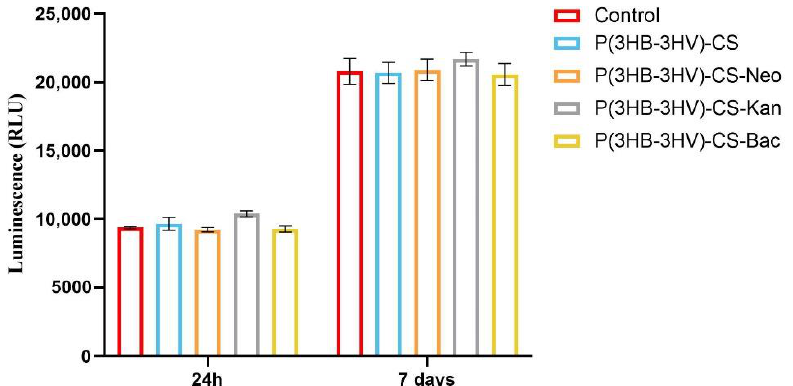
Figure 7. Graphic representation of the H 2 O 2 levels in human dermal fibroblasts cell cultures exposed for 24 h and 7 days at simple and Bac-/Neo-/Kan-loaded P(3HB-3HV)-CS spheres treatment. The represented data are the mean values of three independent experiments ± S.D.